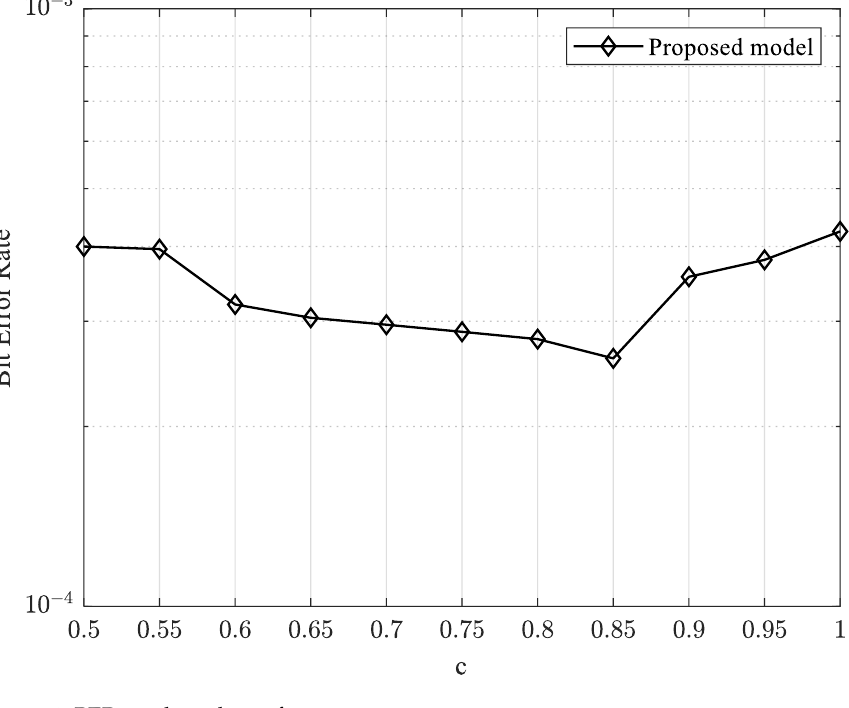
Figure 4. BER vs. the values of c .